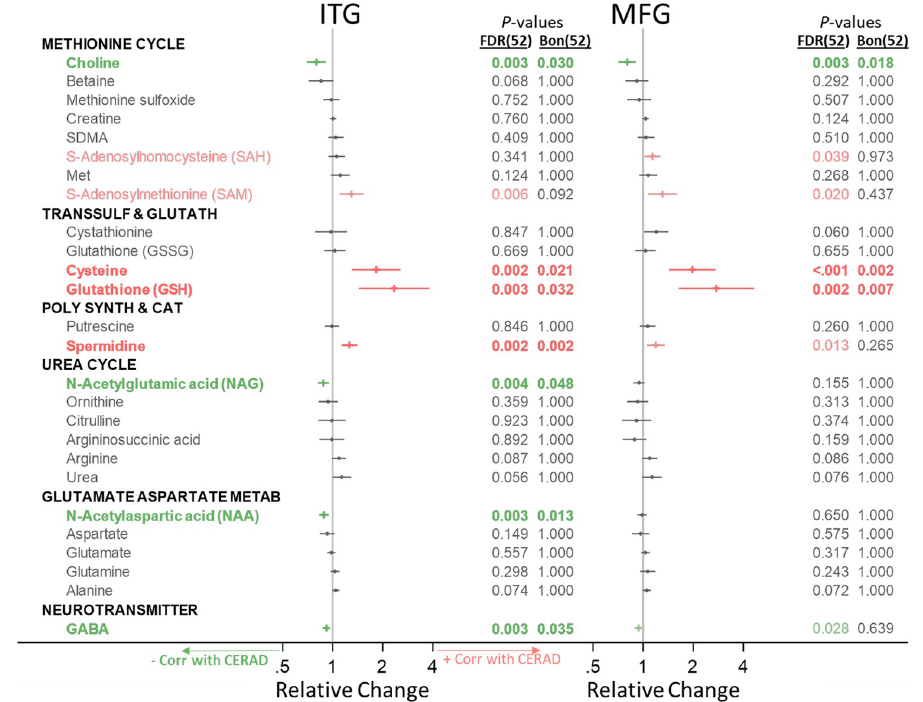
Fig 2. Associations between category-specific metabolites and neuritic plaque burden (CERAD). Metabolites in green or red (not bold) were significant after FDR correction for 52 comparisons; metabolites in green or red (bold) were also significant after Bonferroni correction for 52 comparisons. Associations with pathology were tested using linear mixed-effects models for each metabolite category. Bon, Bonferroni; CERAD, Consortium to Establish a Registry for Alzheimer’s Disease; FDR, false discovery rate; Glutamate Aspartate Metab, glutamate-aspartate metabolism; ITG, inferior temporal gyrus; MFG, medial temporal gyrus; Poly Synth & Cat, polyamine synthesis and catabolism; Transsulf and Glutath, transsulfuration and glutathione synthesis.